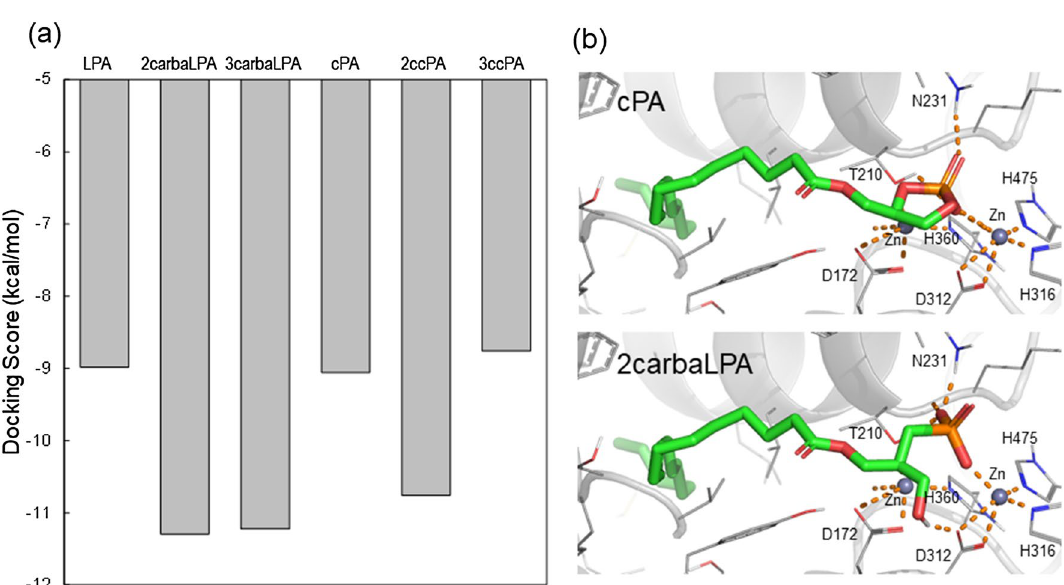
Figure 6. Docking simulation of cyclic phosphatidic acid (cPA) analogues and autotaxin (ATX). ( a ) Grey colour indicates the docking score of cPA analogues. ( b ) Proposed models for cPA (top) and 2-carba- lysophosphatidic acid (2carbaLPA, bottom) binding to ATX (diagram representation coloured in grey) from docking simulation. ATX residues around the compounds within 4 Å and compounds are shown in grey line and green stick representation, respectively. Polar interaction between ATX and the compounds are depicted by orange dots. The structural models in the figures were depicted using PyMOL version 2.4 software (Schrödinger,